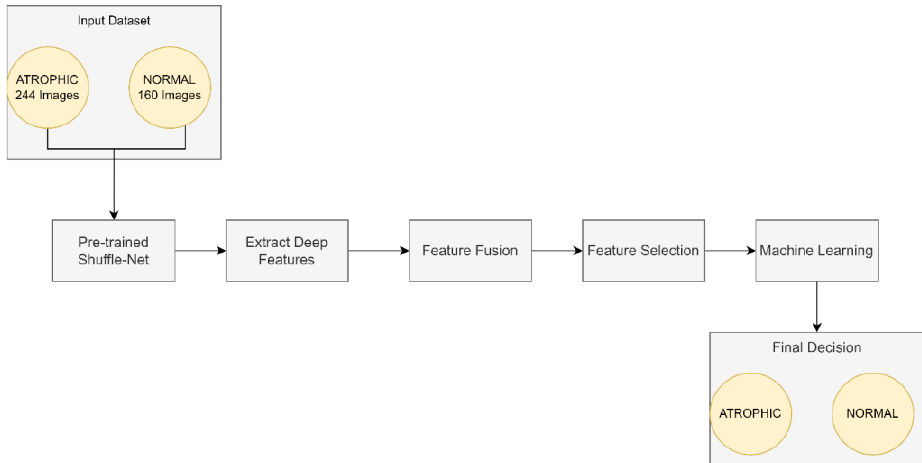
Figure 4. The proposed method for atrophic gastritis detection.